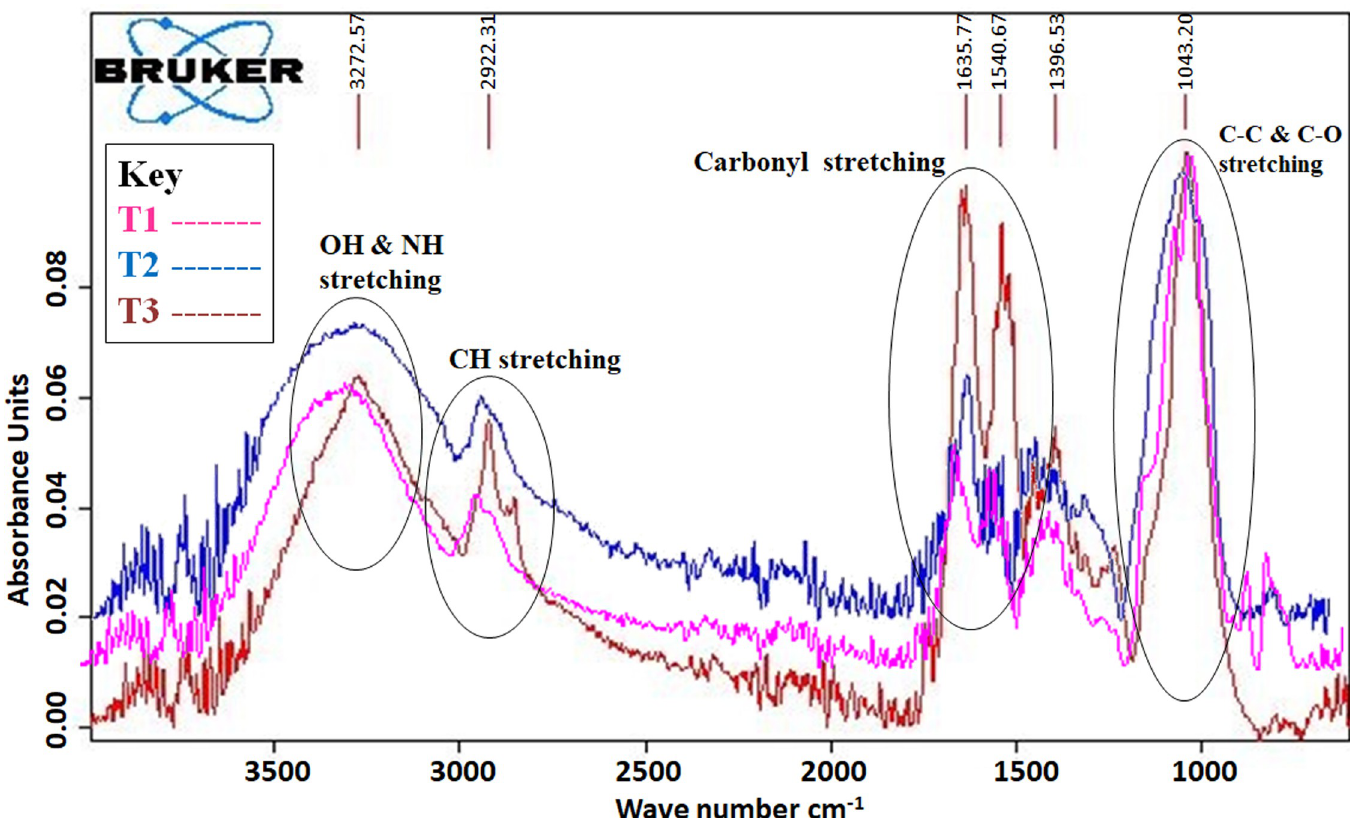
Fig 3. FT-IR spectra of the T1 (untreated maize grains; Pink line), T2 (MRS broth + A . flavus treated maize grains; Blue line), and T3 (CFS + A . flavus treated maize grains; Brown line).